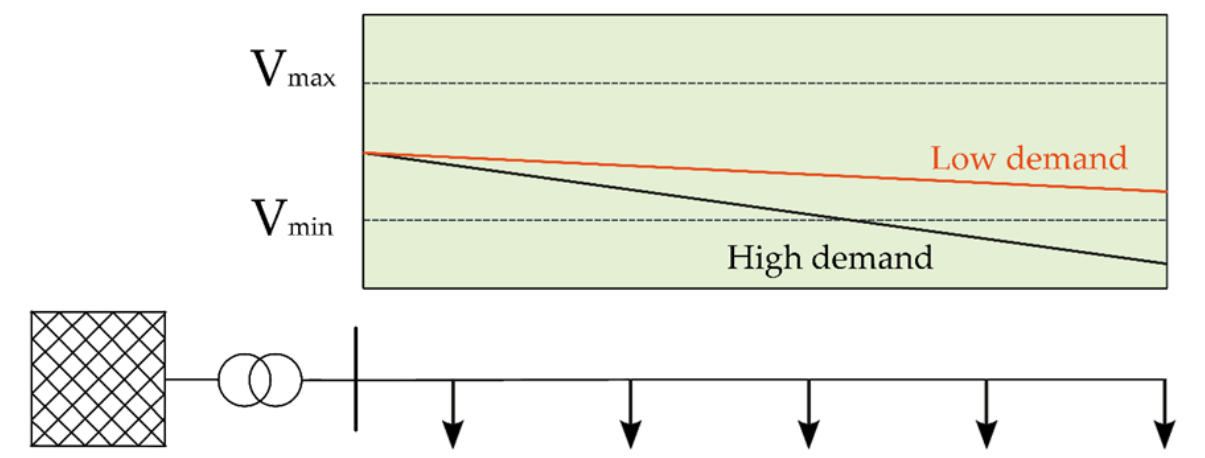
Figure 1. Voltage profile in traditional distribution networks without voltage regulation.